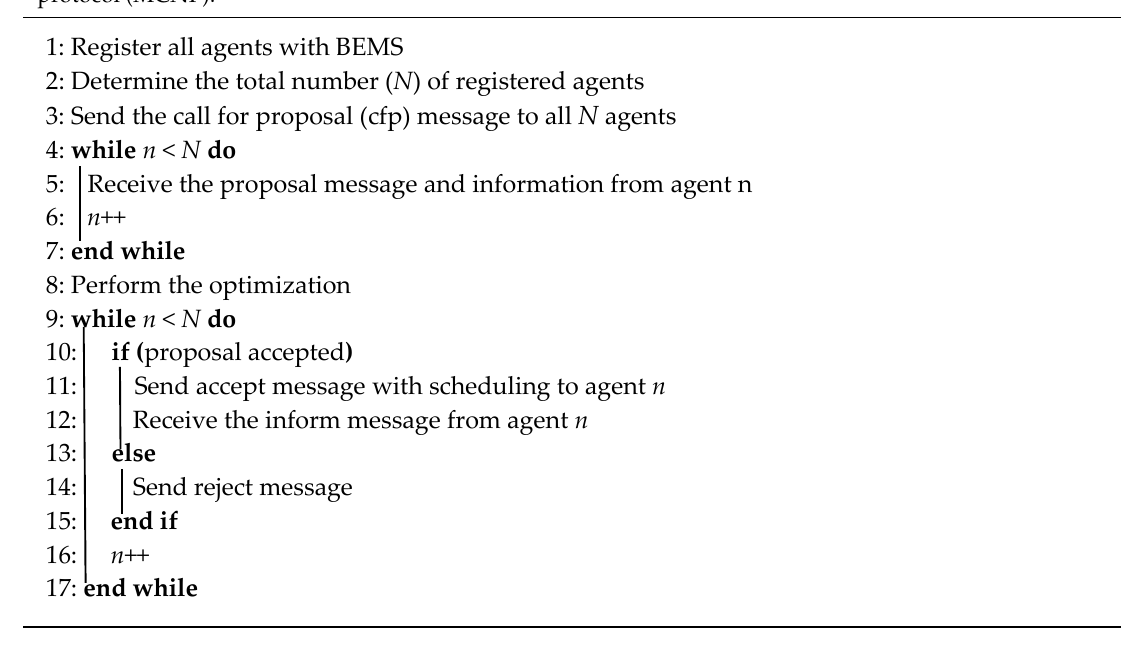
Algorithm 1. Communication among BEMS agent and outer level agents using modified contract net protocol (MCNP).